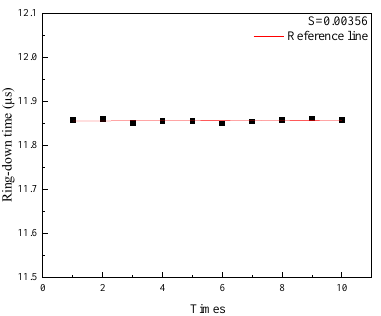
Figure 11. The repeatability of single-point measurement.